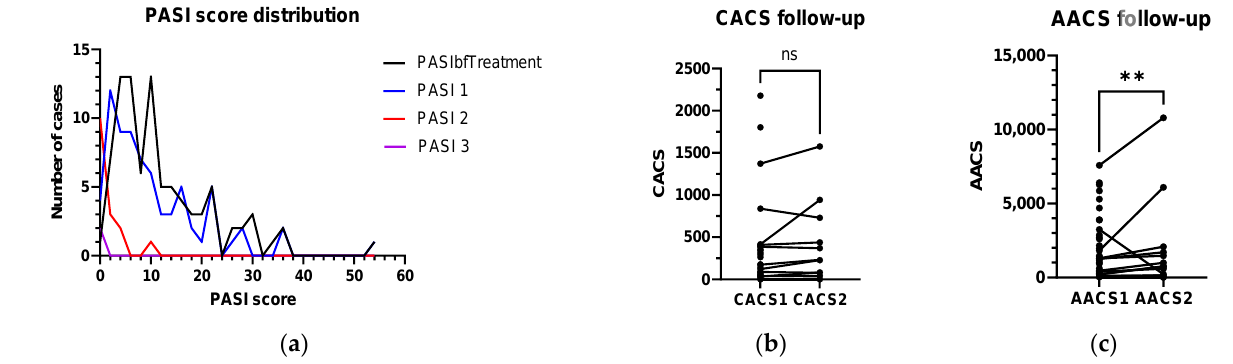
Figure 5. ( a – c ) : Progress of PASI score, CACS, and AACS during the follow-up period. (with **: p < 0.01, “ns”: not significant) **: p < 0.01, “ns”: not